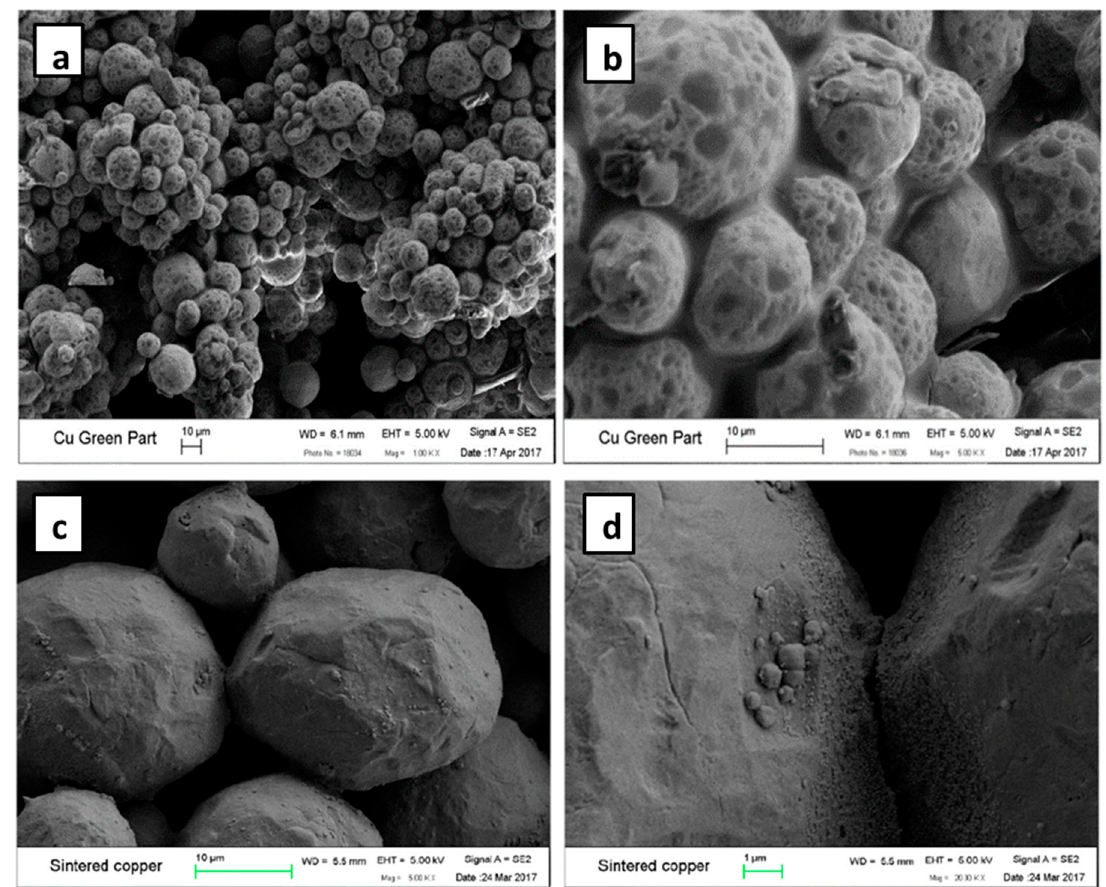
Figure 10. Micrographs of copper parts printed with metal-organic-deposition ink (150% binder saturation ( a ) green and without curing at magnification of 1kx, ( b ) green and without curing at magnification of 5kx, ( c ) bonding formed by sintering of copper nanoparticles at magnification of 5kx ( d ) sintered at magnification of 20kx [91] .